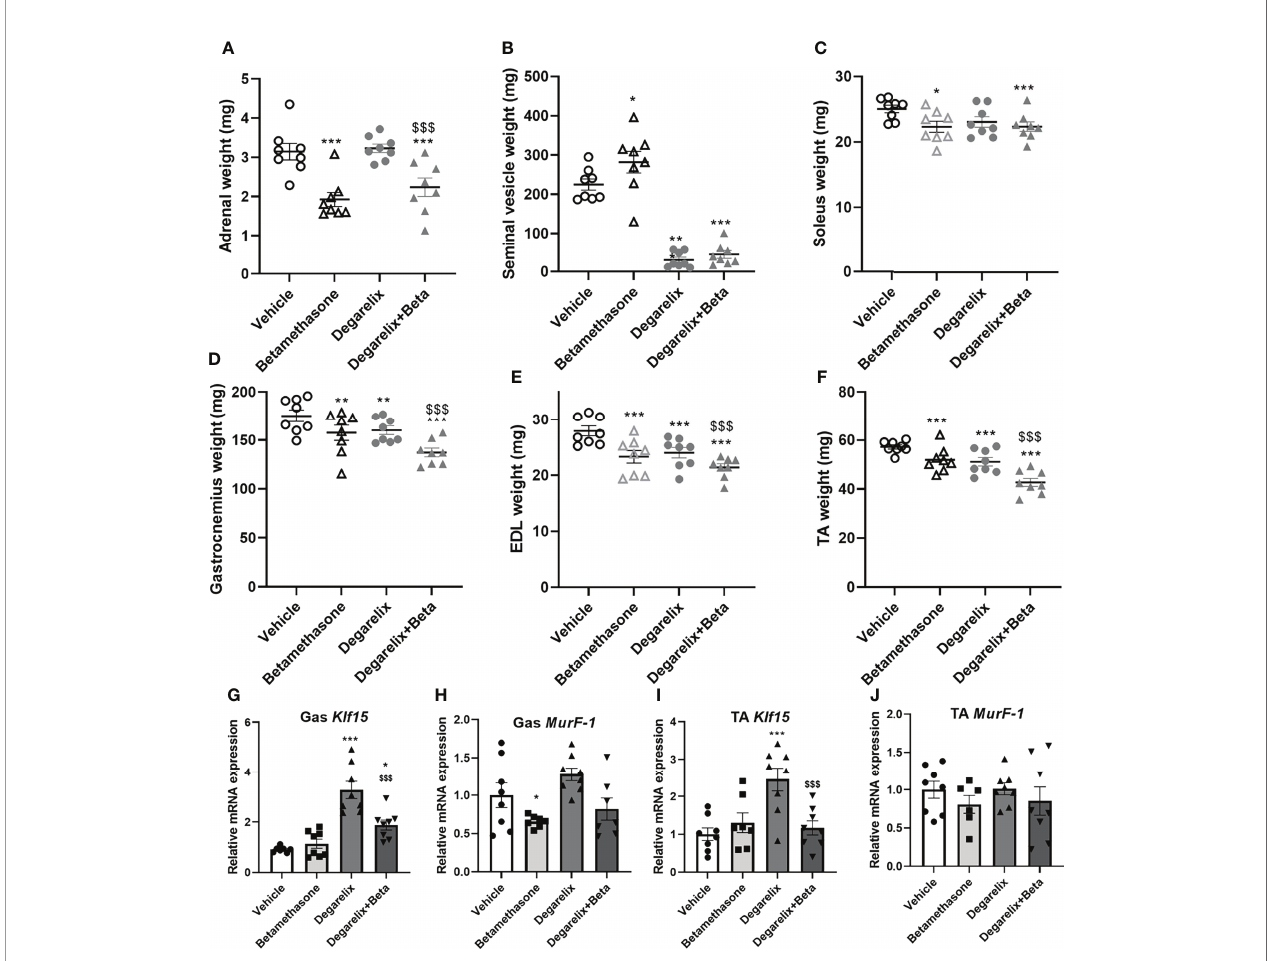
FIGURE 8 | Chemical castration and daily betamethasone treatment additively decrease muscle weight in male mice. The effect of daily treatment with 3 mg/kg betamethasone on intact and chemically-castrated male mice on weight of the (A) adrenal gland, (B) seminal vesicle, (C) soleus, (D) gastrocnemius muscle, (E) extensor digitorum longus (EDL) and (F) tibialis anterior (TA). The effect of daily treatment with 3 mg/kg betamethasone on intact and chemically-castrated male mice on expression of (G) Klf15 in gastrocnemius, (H) MurF-1 in gastrocnemius, (I) Klf15 expression in TA, and (J) MurF-1 expression in TA. N=8 mice/group. *p<0.05 vs. Vehicle, **p<0.01 vs. Vehicle, ***p<0.001 vs. Vehicle, $$$ p<0.001 vs degarelix. Statistical signi fi cance was calculated using a two-way